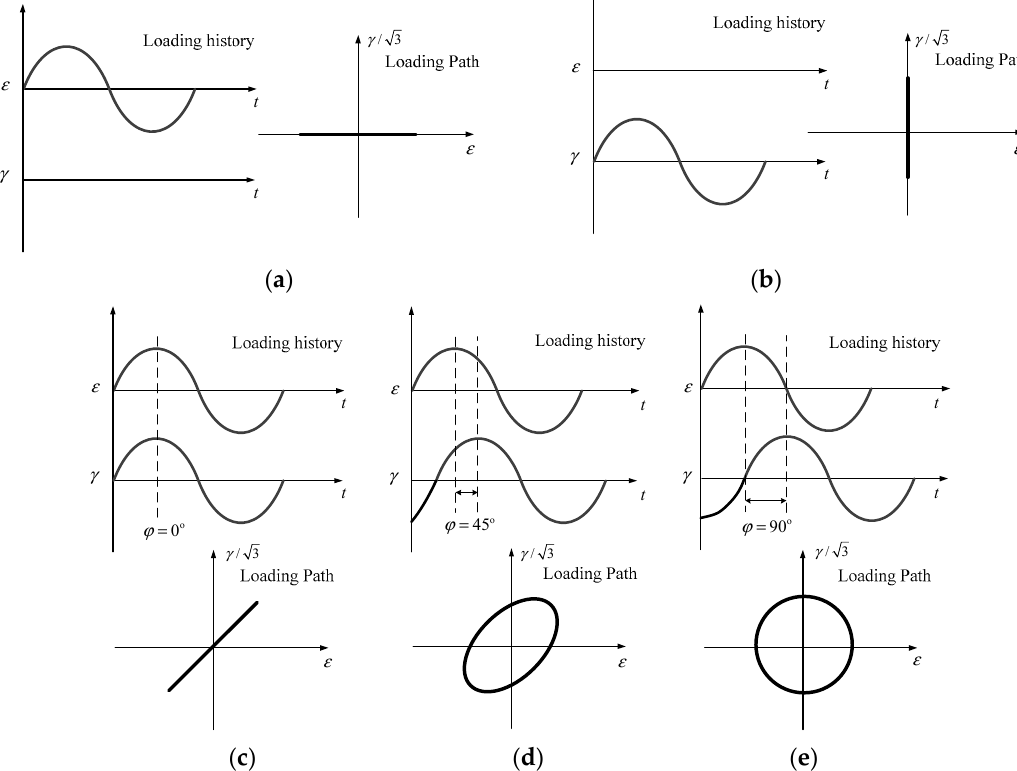
Figure 4. The loading history and loading path under symmetric loadings for the fatigue tests: ( a ) Pure axial loading; ( b ) Pure torsional loading; ( c ) In-phase loading; ( d ) 45 ◦ out-of-phase loading; ( e ) 90 ◦ out-of-phase